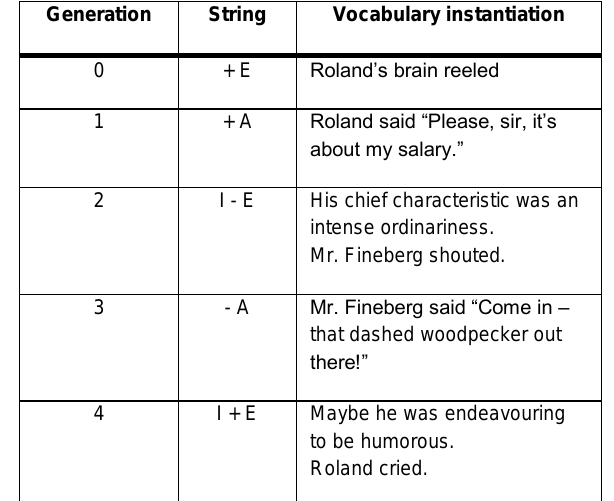
Table 1 | Successive